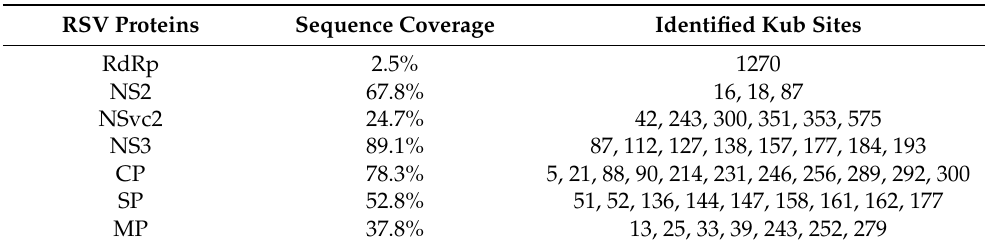
Table 4. Overview of the RSV proteins identified in the proteome data and the identified Kub sites in RSV proteins.